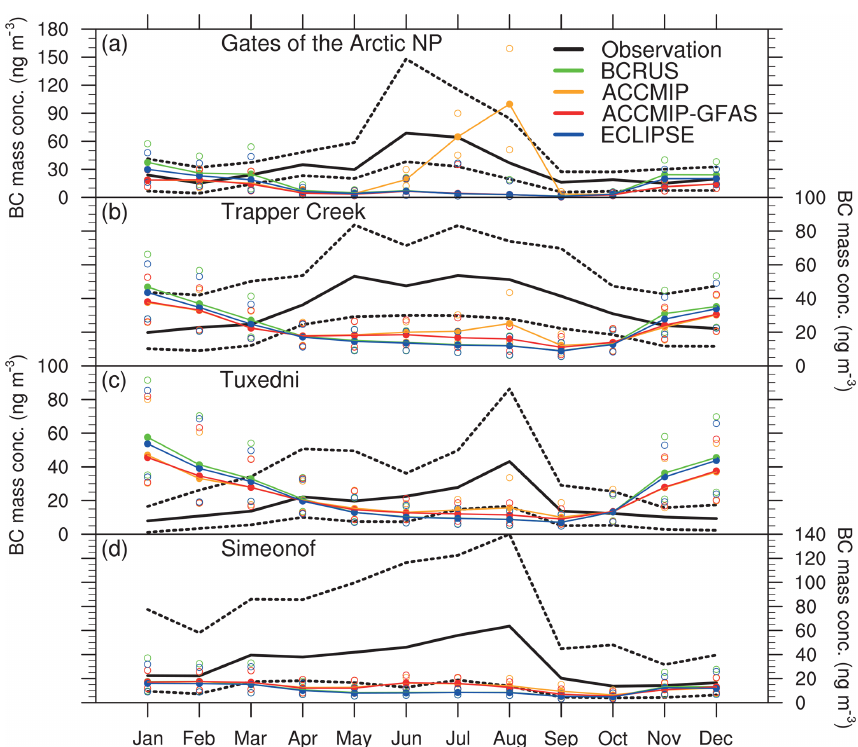
Figure 8. As in Fig. 6 for the American Arctic stations of the IMPROVE network in Gates of the Arctic NP (a) , Trapper Creek (b) , Tuxedni (c) and Simeonof (d)